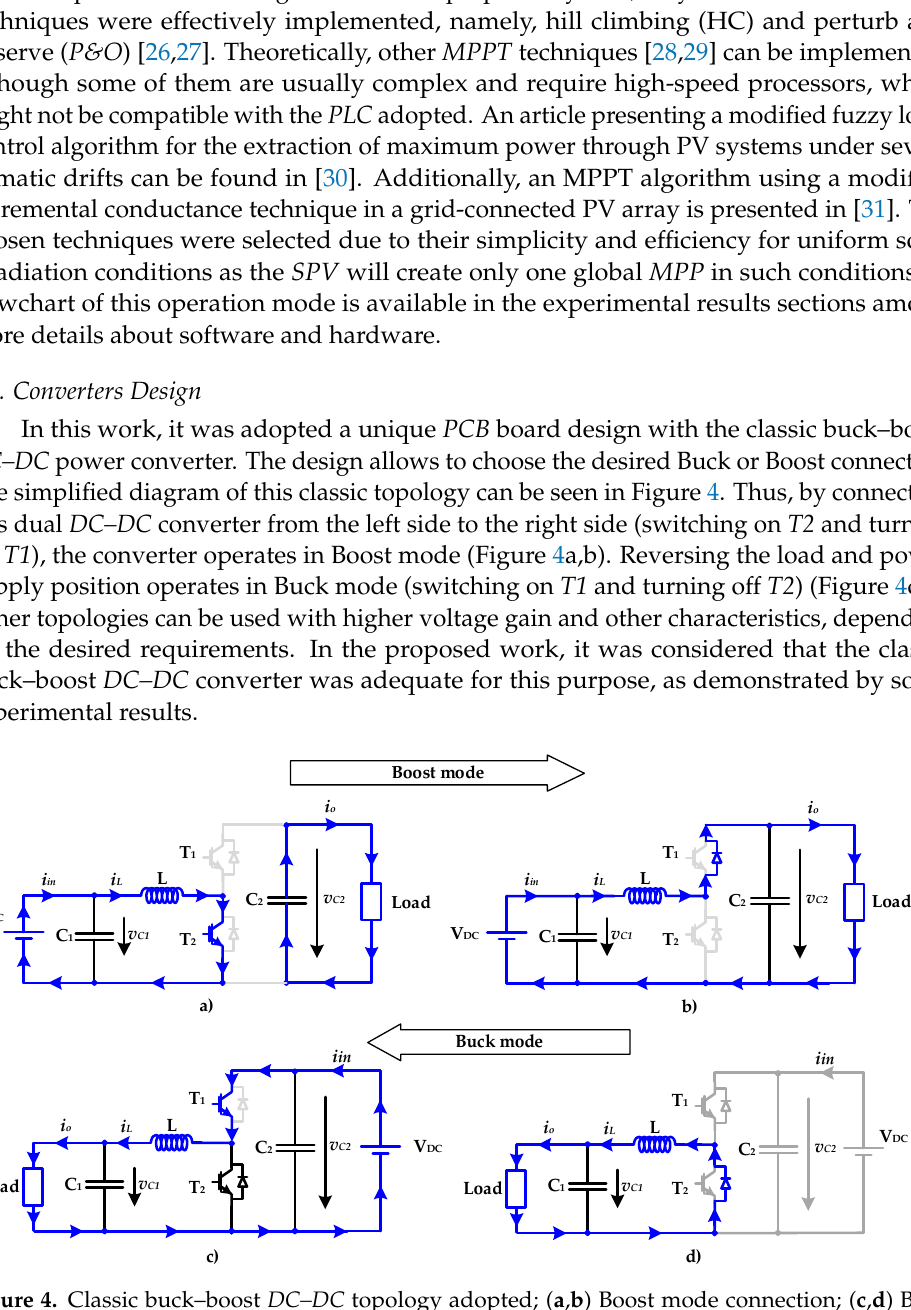
Figure 4. Classic buck–boost DC–DC topology adopted; ( a , b ) Boost mode connection; ( c , d ) Buck mode connection.